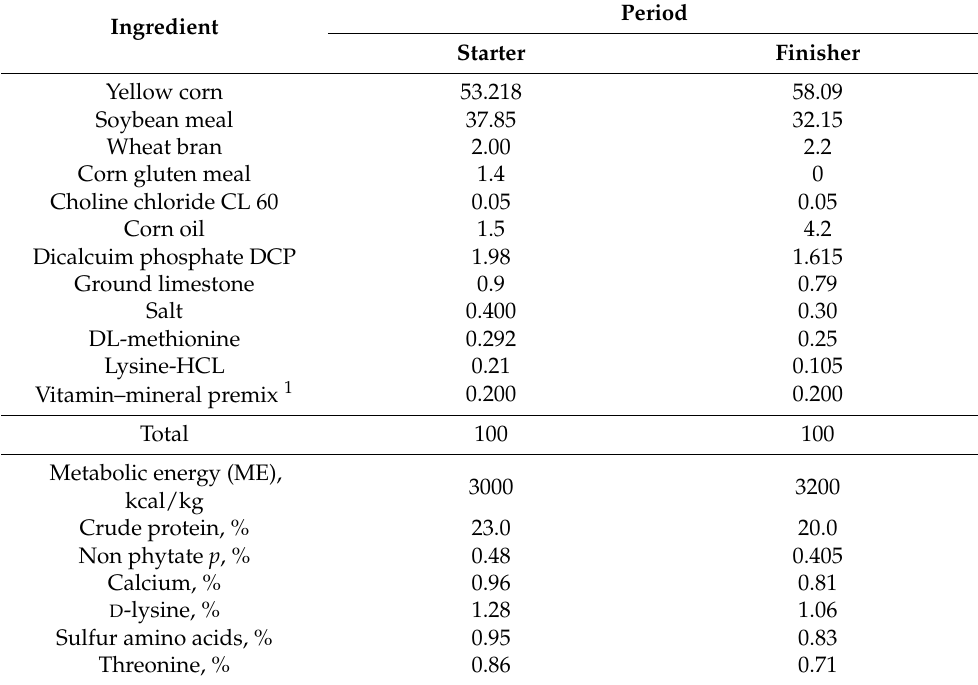
Table 1. Ingredients and calculated nutrients of broiler starter and finisher